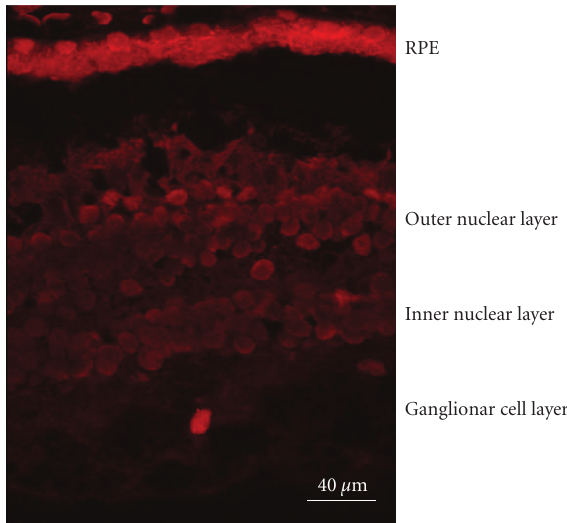
Figure 2: Confocal microscopy showing the expression of somato- statin (SST) in the human retina. As can be appreciated SST expression (in red) is higher in the RPE than in the neuroretina.